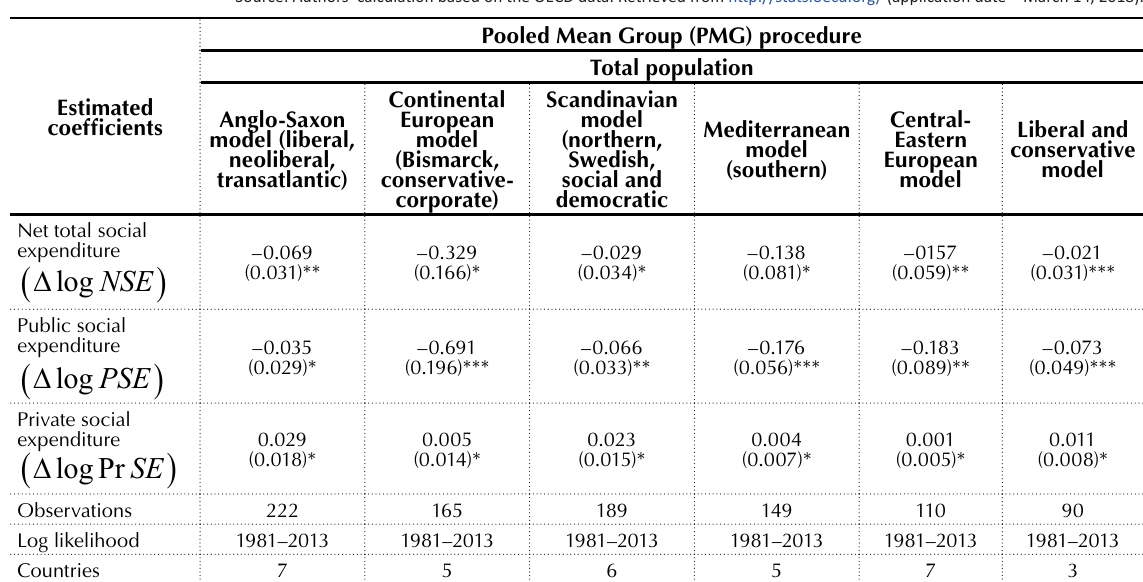
Table 9. Assessment of the social expenditure impact (public and private) on economic growth according to social policy